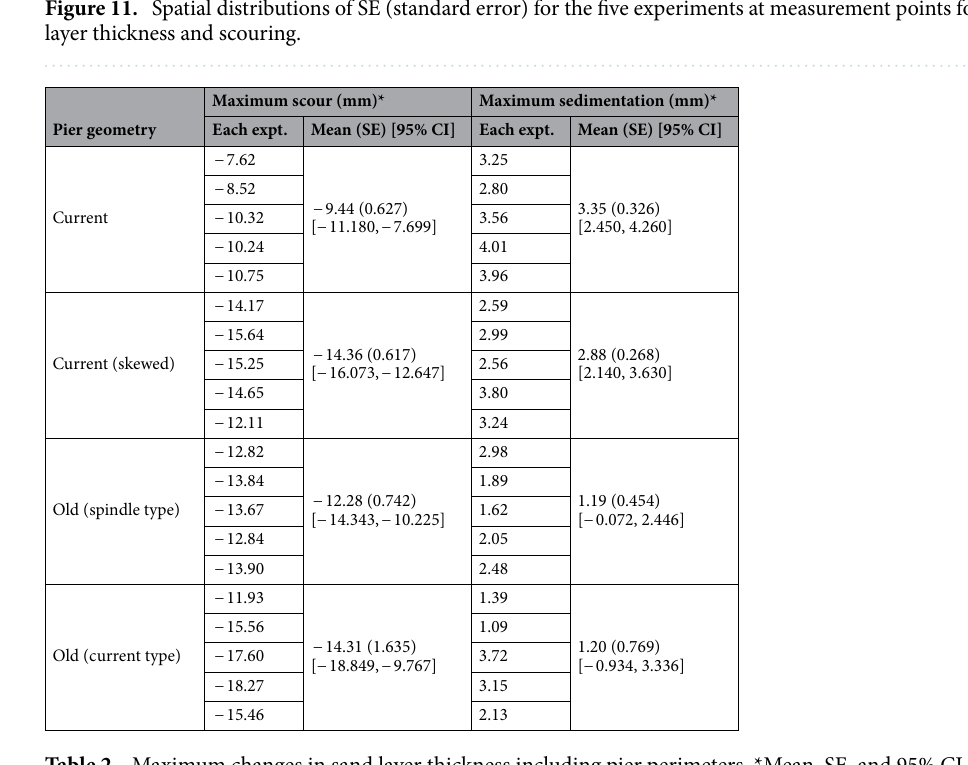
Table 2. Maximum changes in sand layer thickness including pier perimeters. *Mean, SE, and 95% CI at measurement points as well as the largest values in the five experiments are listed.